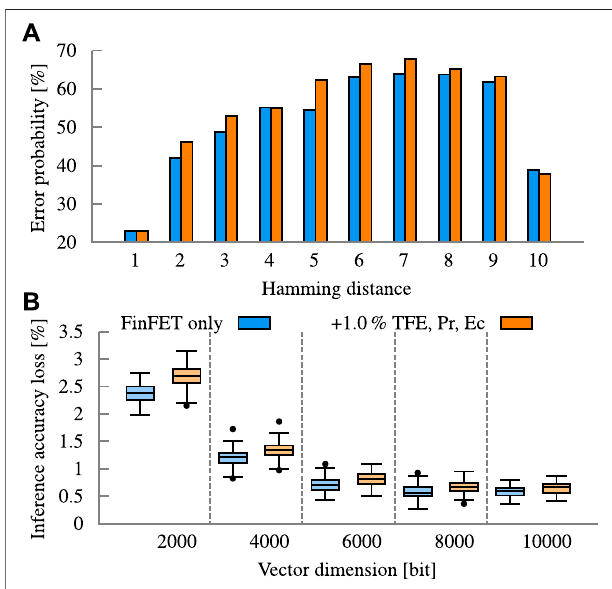
FIGURE15| Ferrovariabilityanalysisthroughvariationofferrothickness (TFE),remnantpolarization( P R )andcoercive fi eld( E C )ontopofthevariationof theunderlyingFinFET. (A) Errorprobabilityofthedifferentvariationsetups. (B) Inference accuracy loss due to the injected error of the variation